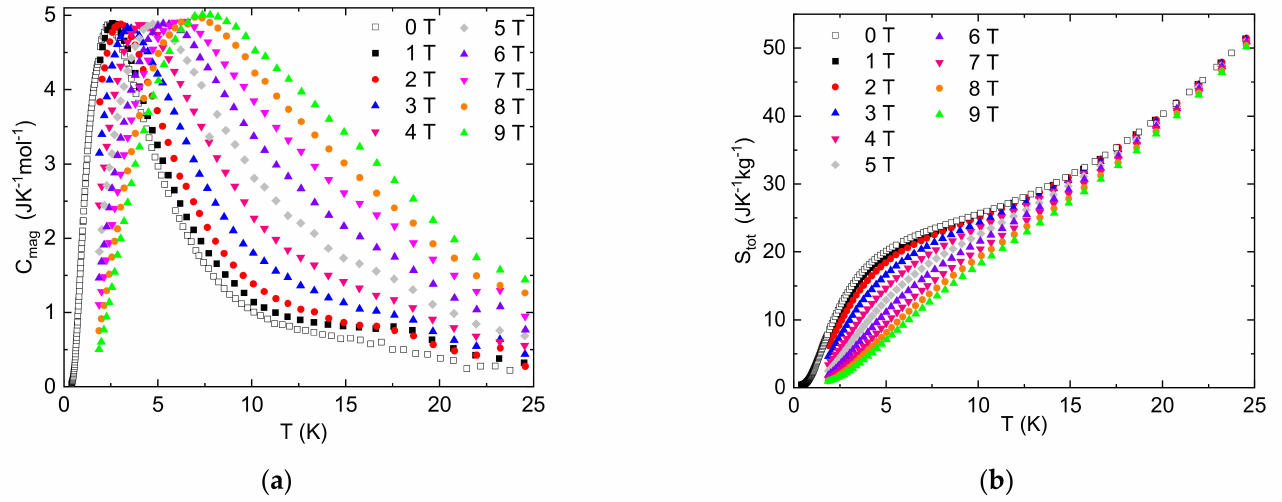
Figure 4. ( a ) Temperature dependence of the specific heat of the magnetic subsystem of the system NiHmal in different magnetic fields; ( b ) Temperature dependence of the total entropy of NiHmal in different magnetic